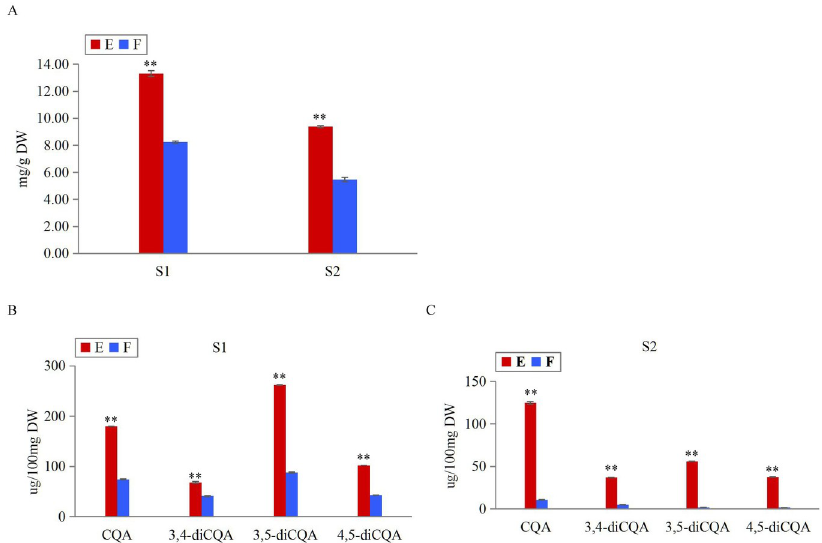
Fig 2. Measurements of TP and CGA contents between genotypes E and F at stages S1 and S2. (A) Measurements of TPC in genotypes E and F at stages S1 and S2. (B) Measurements of CGA monomers in genotypes E and F at S1. (C) Measurements of CGA monomers in genotypes E and F at S2. Error bars indicated ± SD (N = 3). �� T-TEST, P <